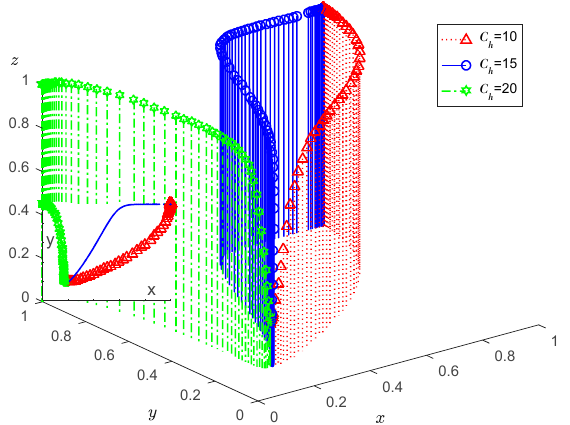
Figure 9. Simulation of evolutionary strategies of producers under different traceability costs.